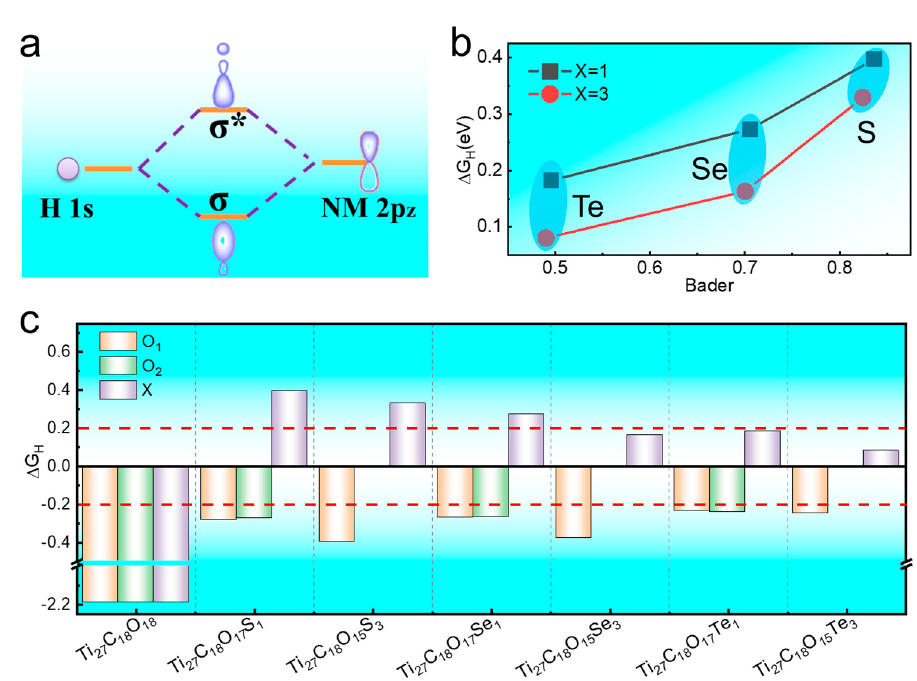
Figure 2. ( a ) The mechanism of hydrogen atom adsorption on nonmetal; ( b ) the relationship between catalytic activity and Bader charge transfer; ( c ) Δ G H of 2D-Ti 2 CO 2 with different T doping concentrations at different H adsorption equivalent sites. When | Δ G H | ≤ 0.2 eV, it indicates the material possess catalytic activity for HER.